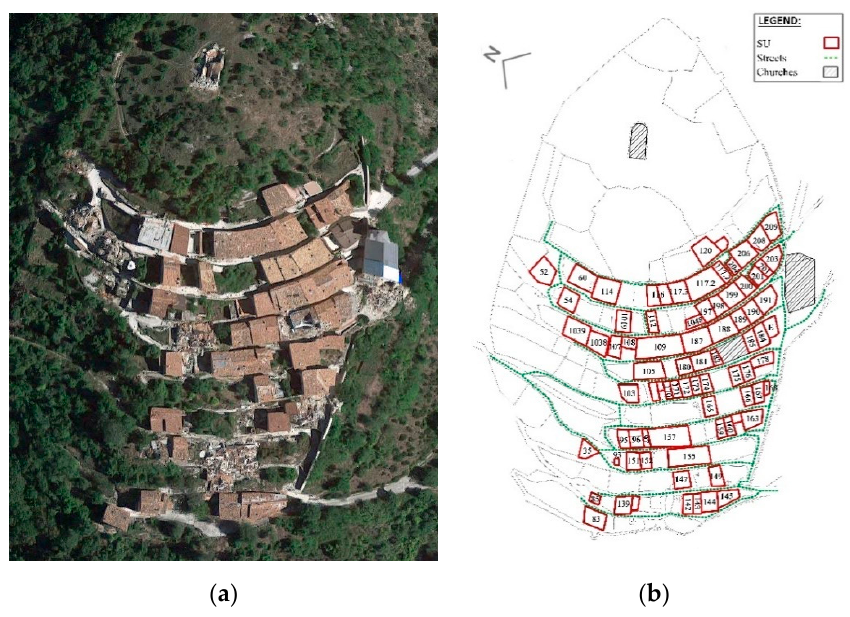
Figure 2. ( a ) View of Campi Alto di Norcia after the 2016 earthquakes; ( b ) identification of structural units, highlighted in red and identified with different IDs, within Campi.